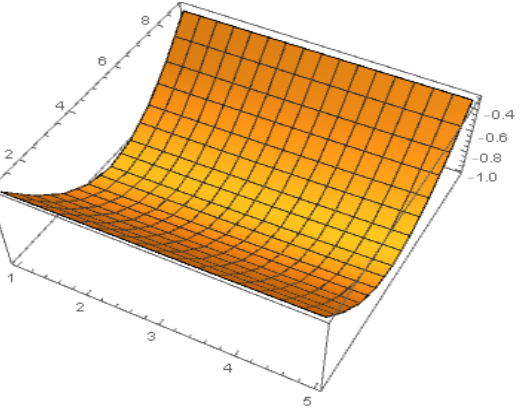
0 Table 2. Numerical solution of Equation (31) by CTCS and implicit at 𝑡 = 0.05 and 𝑥 = 0.9 for 𝑟, 𝛽 ∈ [0,1]. CTCS